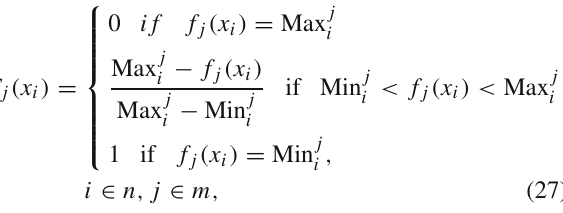
defined as follows.